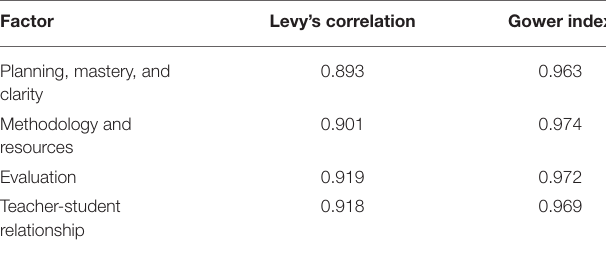
TABLE 2 | Agreement between the long and short forms.